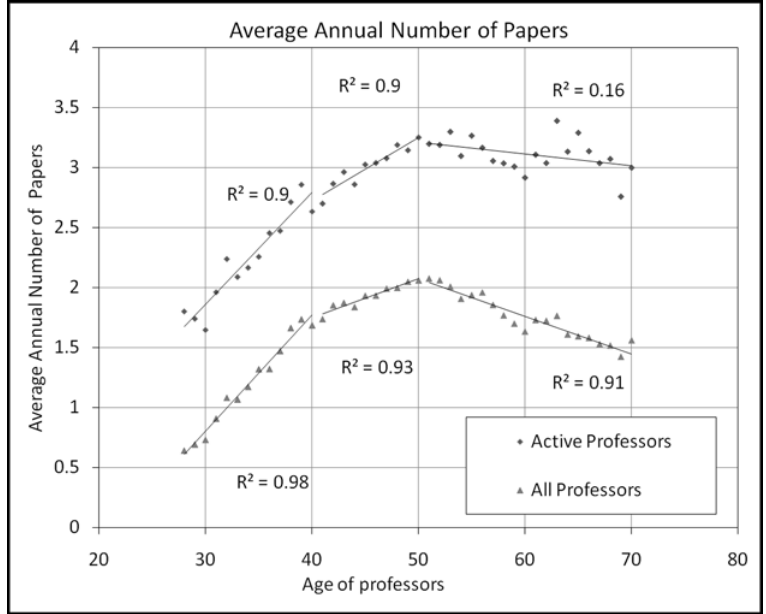
Figure 2. Distribution of research productivity by age. A) Average annual number of papers for professors who publish (Active) and for all professors.